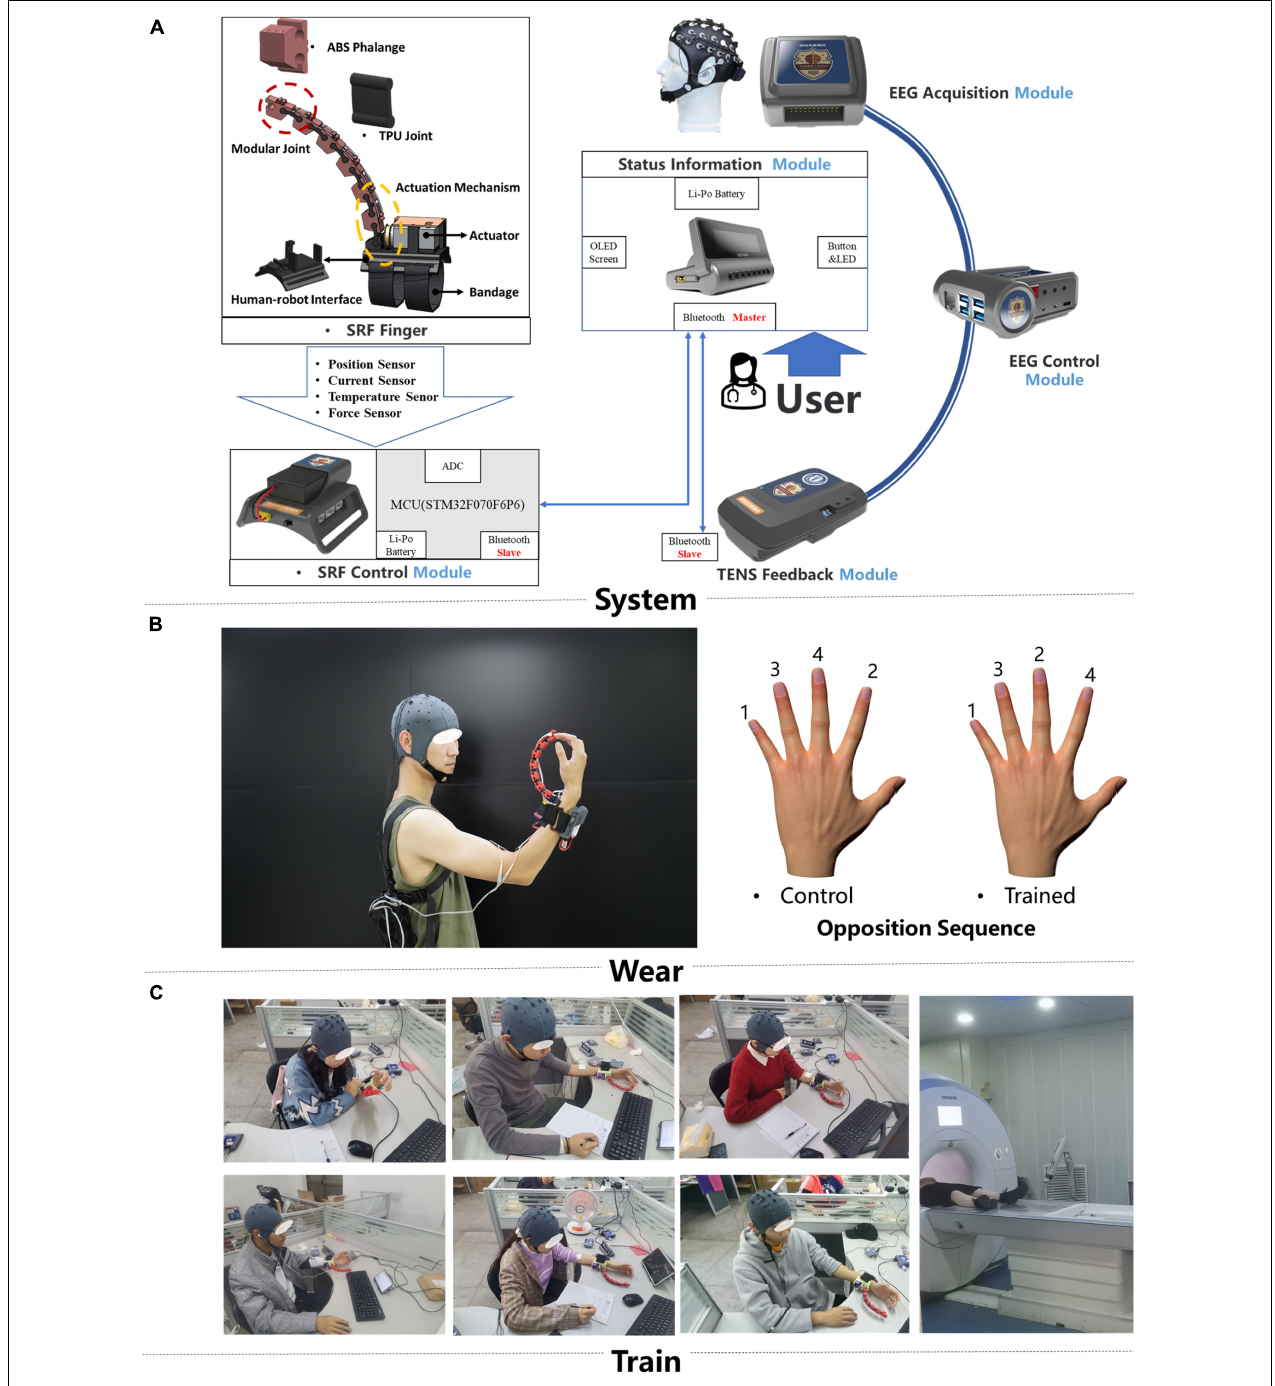
FIGURE 1 | Training system and intervention protocols. (A) The hardware design of the brain computer interface (BCI)-controlled supernumerary robotic finger (SRF) system and the signal transmission diagram (B) . The display of the portable SRF and behavioral measure paradigm. (C) Scene of subjects wearing SRF